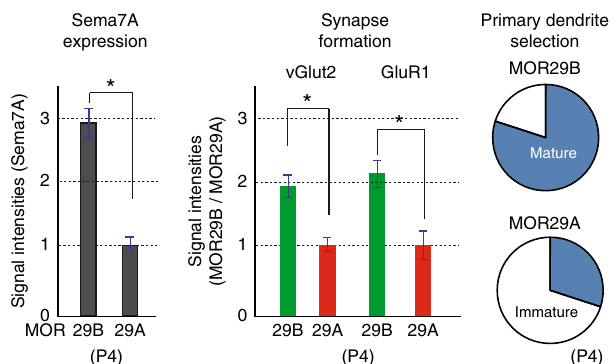
Fig. 6 Sema7A promotes dendrite maturation and synapse formation. Left, Sema7A levels in the MOR29B and MOR29A glomeruli. OB sections at P4 were immunostained with anti-Sema7A antibodies, and signal intensities of Sema7A are compared (see also Fig. 1c). * p < 0.05 (Student ’ s t -test). Error bars indicate standard deviation SD ( n = 8 glomeruli). Middle, Pre- and post-synaptic markers in the MOR29A and MOR29B glomeruli. OB sections at P4 were also immunostained with antibodies against vGlut2 and GluR1, pre- and post-synaptic markers, respectively. Relative fl uorescent signals (MOR29B/MOR29A glomeruli) are compared. * p < 0.05 (Student ’ s t -test). Error bars indicate standard deviation SD ( n = 8 glomeruli). Right, Dendrite maturation of M/T cells in the MOR29A and MOR29B glomeruli. M/T-cell dendrites were visualized by LY injection into the MOR29A and MOR29B glomeruli at P4. The ratios (%) of mature and immature M/ T cells in the MOR29A and MOR29B glomeruli are shown: MOR29A, 8/29 (27.6 %); MOR29B, 22/28 (78.6%). n = 16